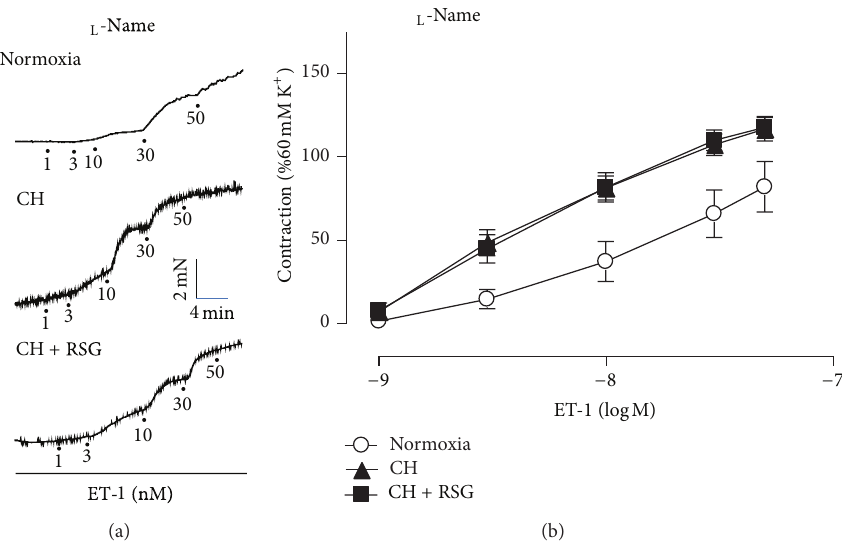
Figure 2: (a) Representative recordings of ET-1-induced contractions pretreated with normoxia-, CH-, or RSG-treated CH-rats. (b) The effect of RSG on ET-1-mediated vasoconstriction was abrogated in the presence of (100 𝜇 mol/L). Data were mean ± SEM from 5 to 7 rats.